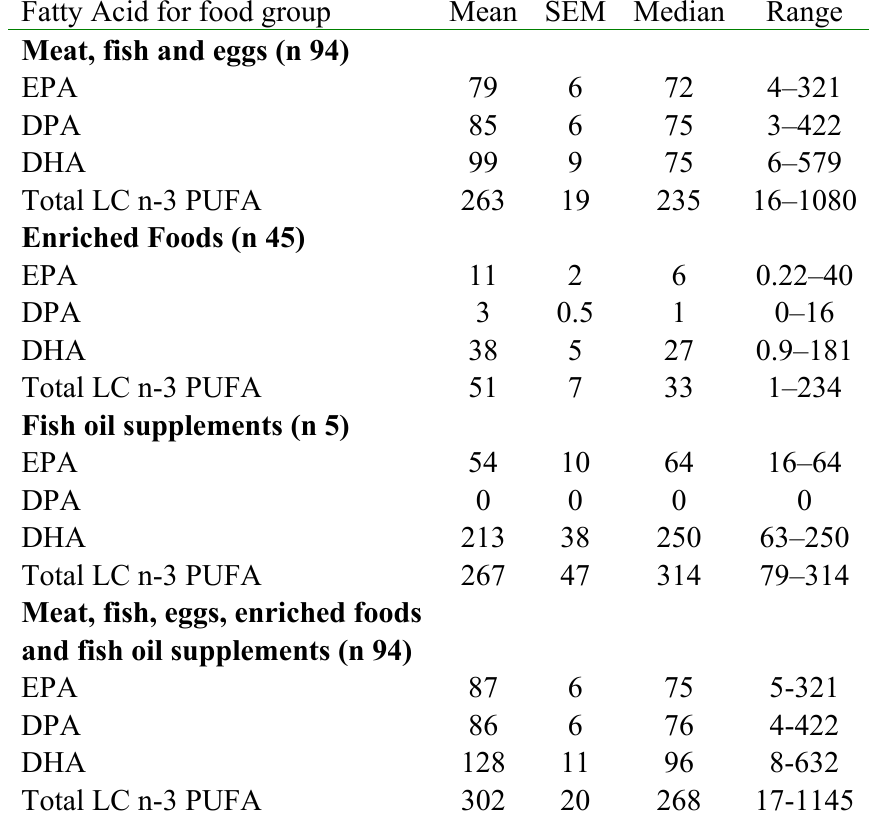
Table 3. Contribution of enriched foods and fish oil supplements in pregnant women to the total LC n-3 PUFA intakes (mg/day) from all sources.